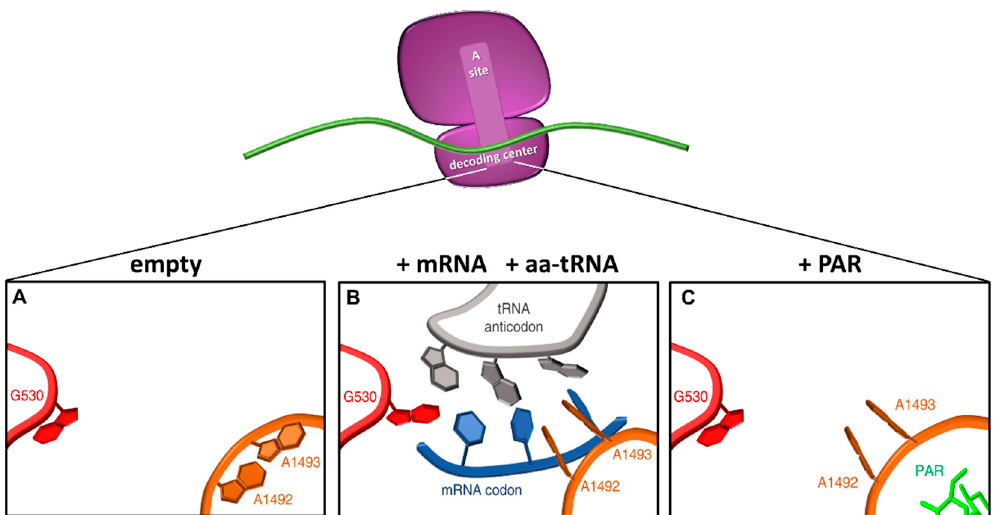
Figure 4. Conformational changes in the decoding center upon tRNA or aminoglycoside binding. Schematic representation of the ribosomal decoding center as derived from PDB 1IBM ( A ), 1IBL ( B ), and 1IBK ( C ) (adapted from [1]). In the native 30S ribosomal subunit, adenines 1492 and 1493 are stacked inside helix 44, and G530 in the syn conformation ( A ). When the correct codon-anticodon loop, formed upon entering of a cognate aa-tRNA, enters the A site, the A1492 and A1493 residues flip out and G530 switches to the anti -conformation ( B ). In the presence of paromomycin (PAR), the A1492 and A1493 residues are similarly flipped out into the A site mimicking the presence of a cognate aa-tRNA. Red, G530 loop; orange, helix 44; grey, tRNA anticodon; blue, mRNA codon; green, paromomycin.